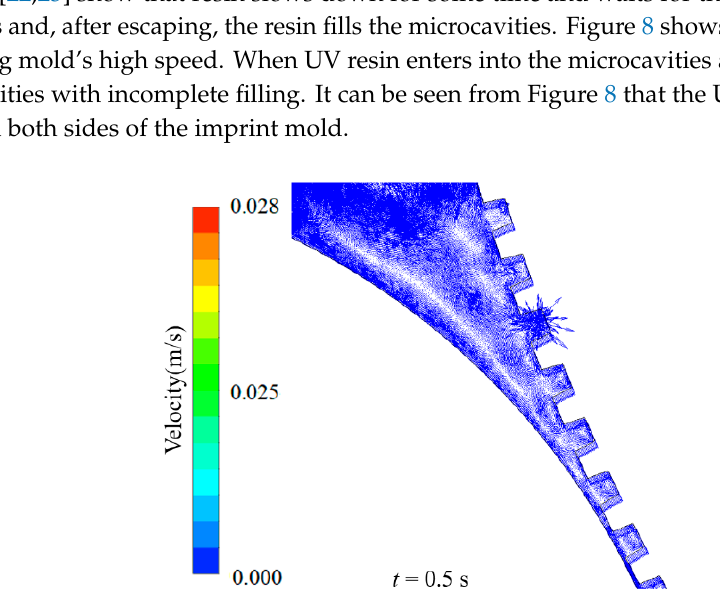
Figure 7. Velocity vectors of the moving and rotating walls at time t = 0.5 s, at a web speed of 24.2 mm/s.